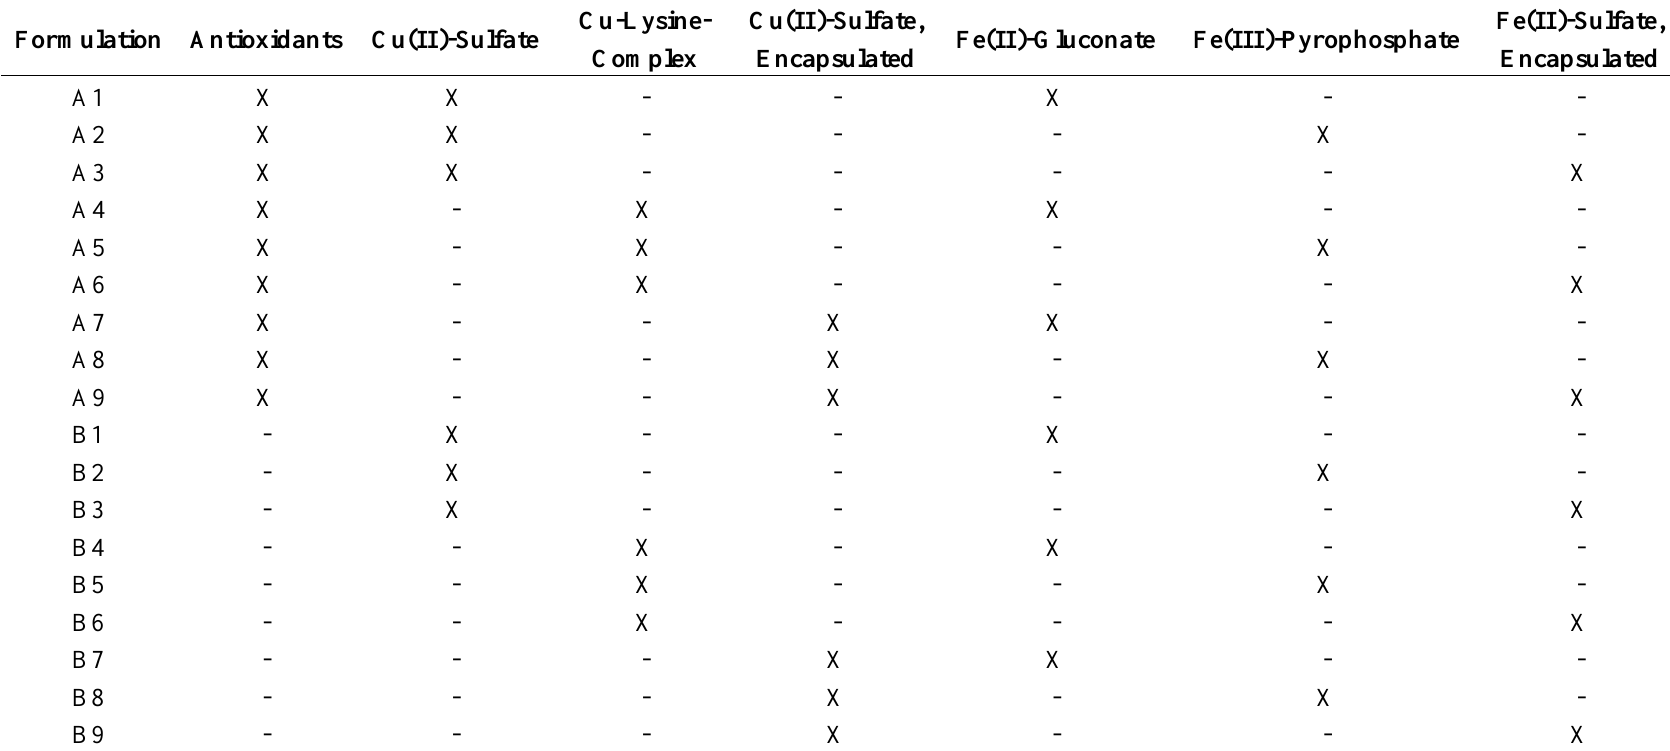
Table 1. Formulations of the manufactured infant formulas with respect to the presence of antioxidants (ascorbyl palmitate and DL -α-tocopherol) and mineral composition in relation to copper and iron ( n formulations = 18). X: used